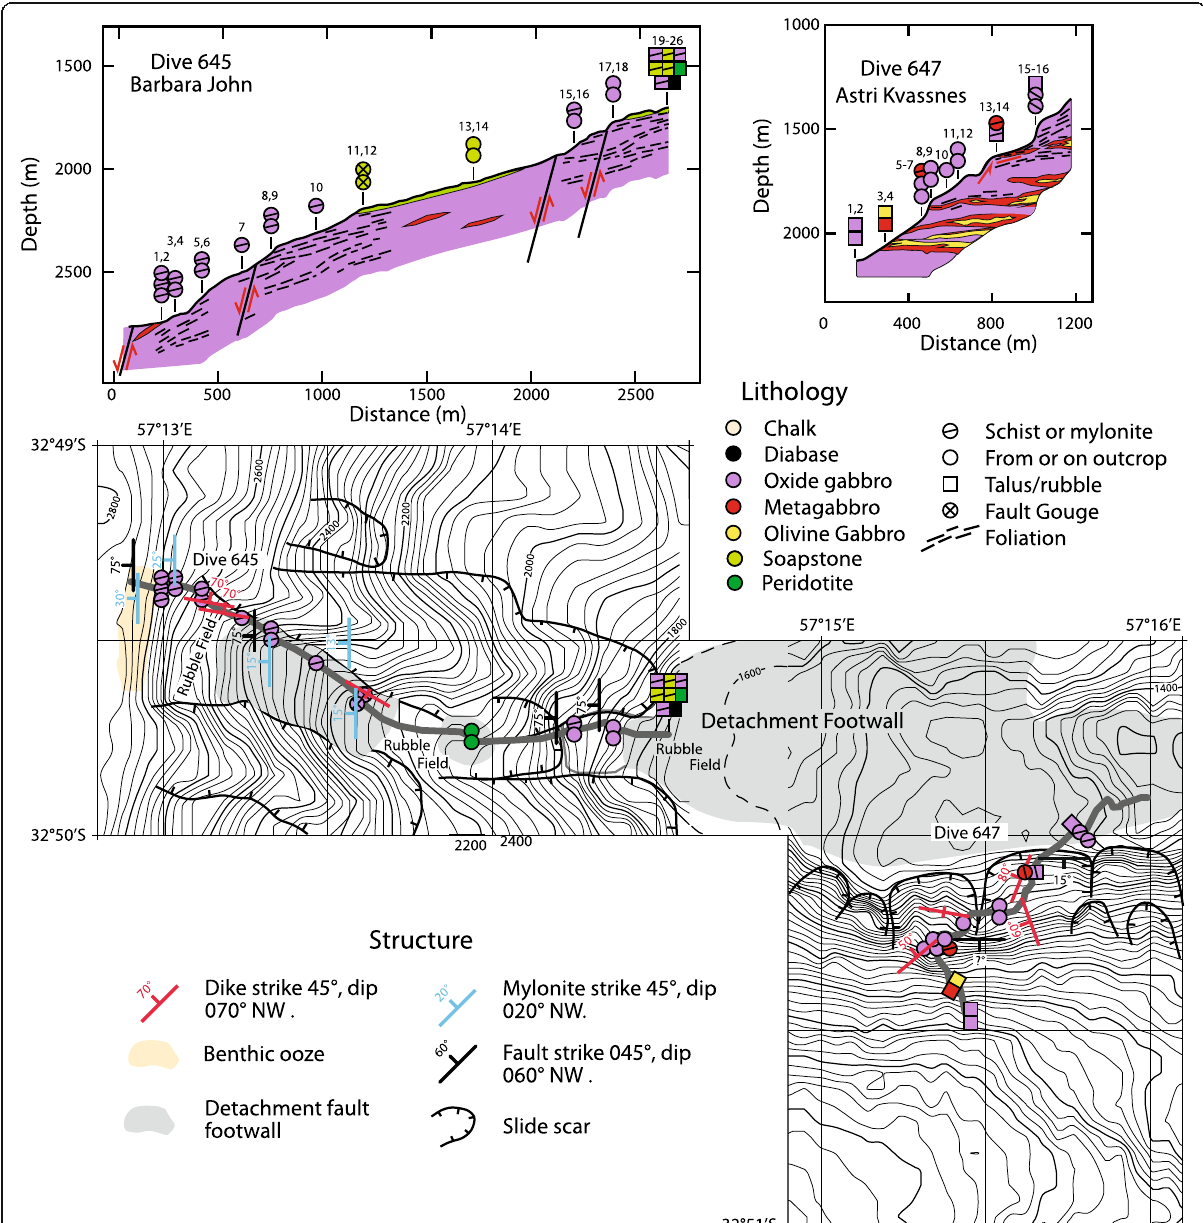
Fig. 41 Interpretive cross-sections and plan views for Dives 6K-645 and 6K-647 (Fig. 3) in the southern region of Atlantis Bank. Dive scientists were B. John and A. Kvassnes as indicated on the